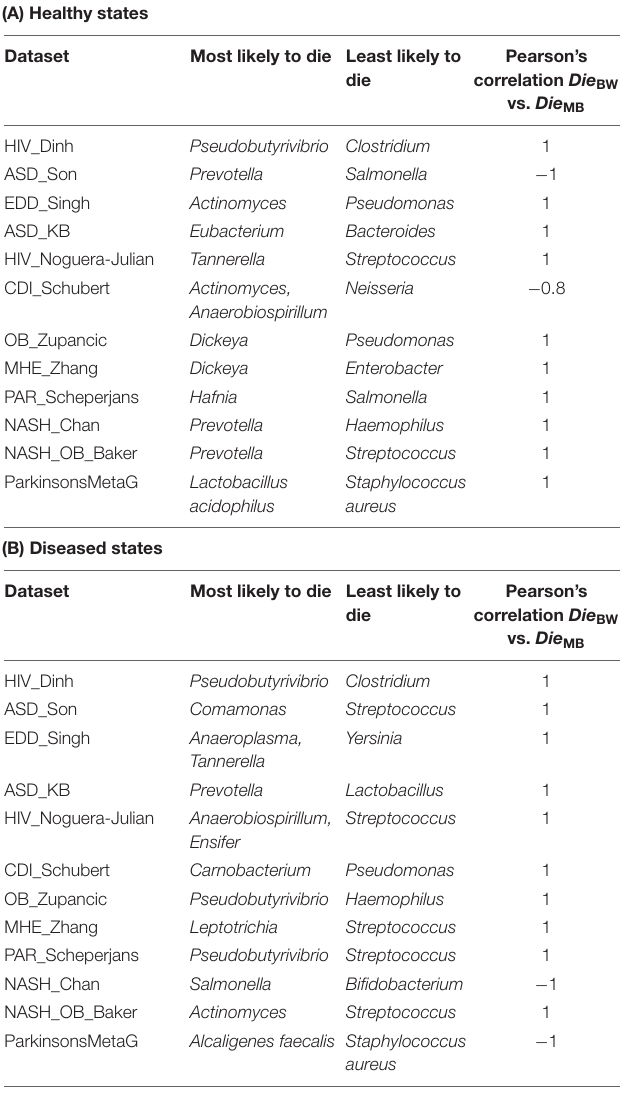
TABLE 2 | Top Die score taxa for healthy and disease MB networks and their correlation with BW Die scores. (A) Healthy states